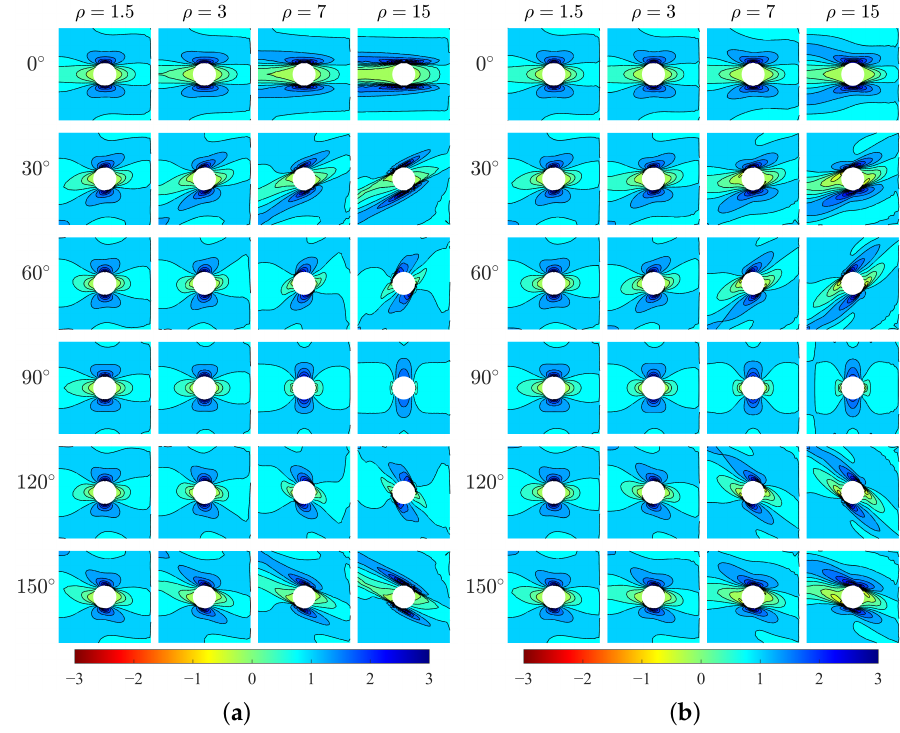
Figure 5. Horizontal stress σ 11 , MPa, ( a ) Cosserat, ( b ) Cauchy.